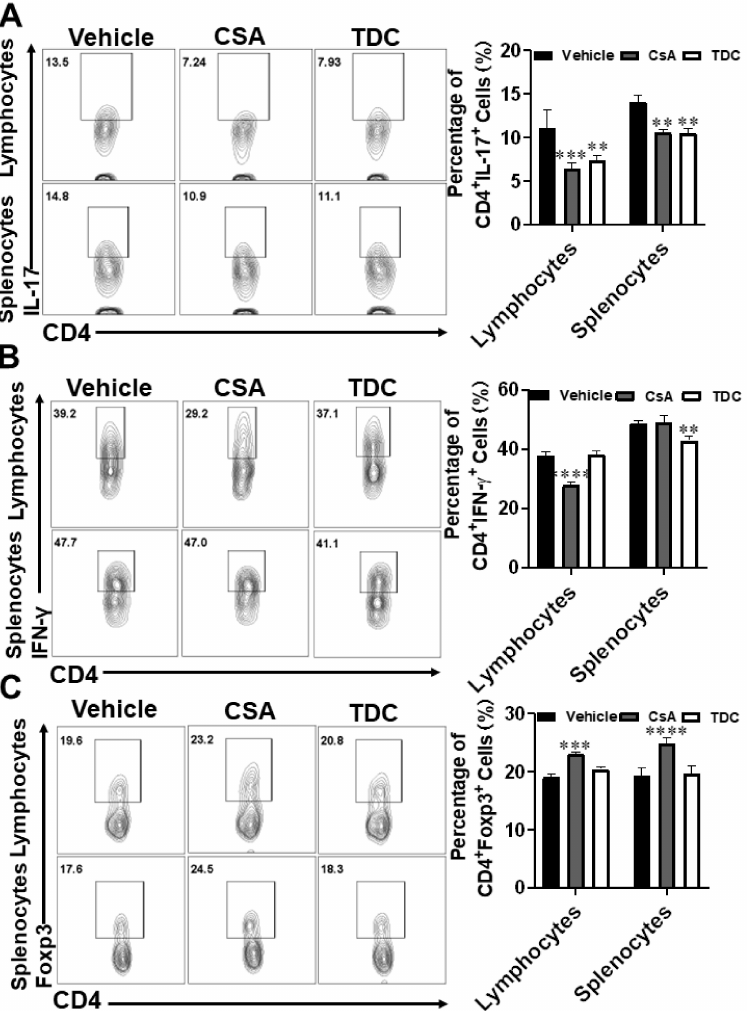
Figure 7. Effects of TDC on Th17, Th1 and Treg cells in splenocytes and lymph nodes of skin transplanted mice. Splenocytes and lymphocytes were prepared in each group at the 8th day after administration. CD4 + IL-17 + , CD4 + Foxp3 + and CD4 + IFN- γ + were detected by flow cytometry. ( A ) Flow cytometric pseudo-color images and statistical results of Th17 cells in different organs. ( B ) Flow cytometric pseudo-color images and statistical results of Th1 cells. ( C ) Flow cytometric pseudo-color images and statistical results of Treg cells in different organs. The results in the panel are expressed as means ± SD and are representative of three experiments ( n = 6 each group), ** p < 0.01, *** p < 0.001, **** p < 0.0001, two-way ANOVA with multiple comparisons